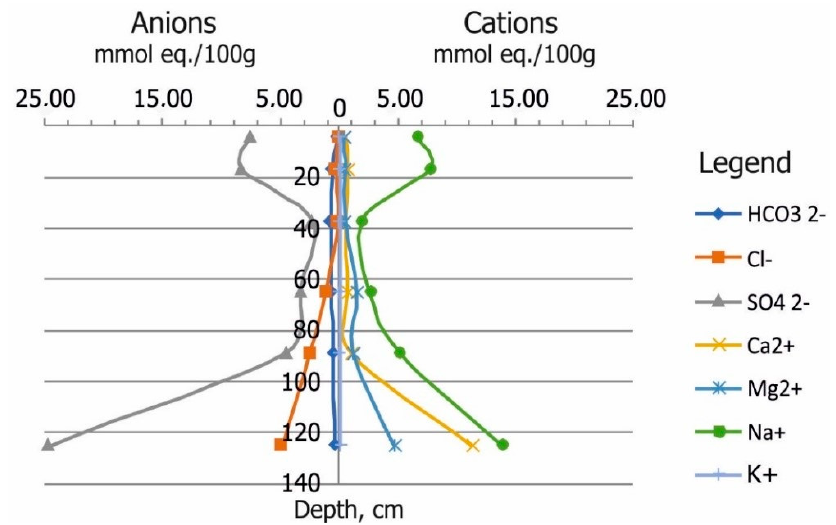
Figure 12. Distribution of salts in water extract.